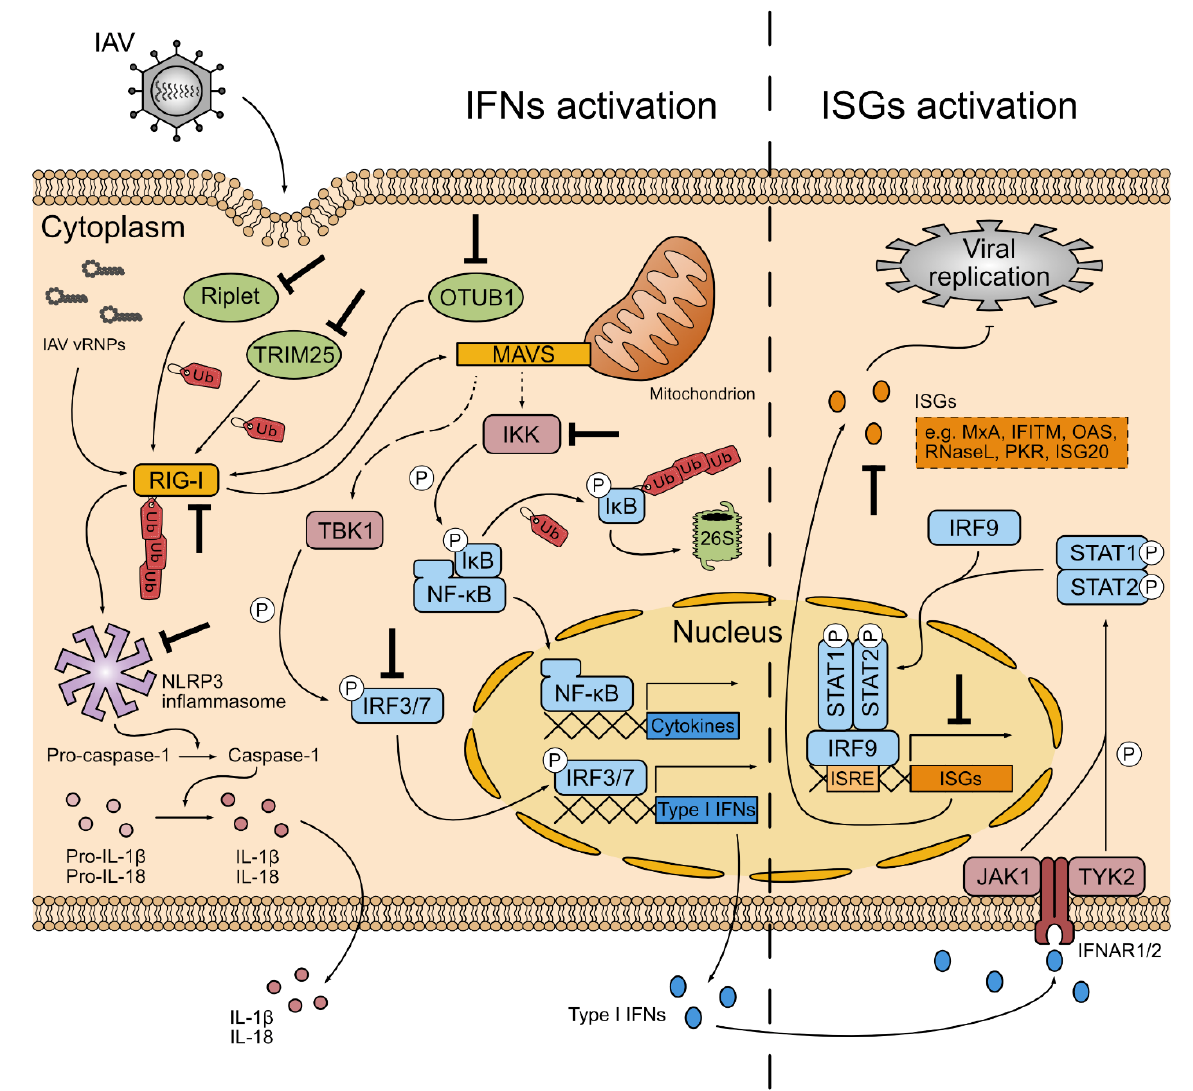
Figure 2. Innate immune response during influenza A virus infection and NS1 hijackings. IFNs activation (left): viral particles are incorporated in the host cell through endosomes formation, leading to vRNPs’ release in the cytoplasm. The RLR sensor RIG-I is then activated by their presence and is K63 poly-ubiquitinated by Riplet and by TRIM25. The DUB OTUB1 also activates RIG-I through inhibition of its K48-linked poly-ubiquitination. In turn, RIG-I activates the NLRP3 inflammasome, that stimulates caspase-1 activation. Caspase-1 then mediates the maturation of interleukins IL-1 β and IL-18, which are then secreted to promote inflammatory response. After its activation, RIG-I mainly binds to MAVS and promotes its multimerization at the mitochondrial membrane. Through signaling cascades not depicted here, MAVS mediates the recruitment of TBK1 and IKK kinases, which phosphorylate IRF3 and IRF7 transcription factors, and the NF- κ B inhibitor I κ B, respectively. I κ B is then poly-ubiquitinated and degraded by the 26S proteasome. Activated IRF3 and IRF7, as well as activated NF- κ B then translocate into the nucleus to promote type I IFNs (IFN α et IFN β ) expression, and pro-inflammatory cytokines, respectively. Notably, NF- κ B also mediates IFN β expression. ISGs activation (right): type I IFNs are then secreted in an autocrine and a paracrine way and bind to IFNAR1/2 heterodimeric receptor. Upon IFN binding, JAK1 and TYK2 kinases are activated and mediate phosphorylation of STAT1 and STAT2 transcription factors. These proteins then translocate into the nucleus with IRF9 and bind to ISRE sequences in ISG promoters to induce their transcription. Several ISGs are known to particularly counteract IAV replication (examples in the orange box). In turn, the NS1 protein hijacks innate immune response by targeting different proteins (bold black arrows), and notably ubiquitin factors